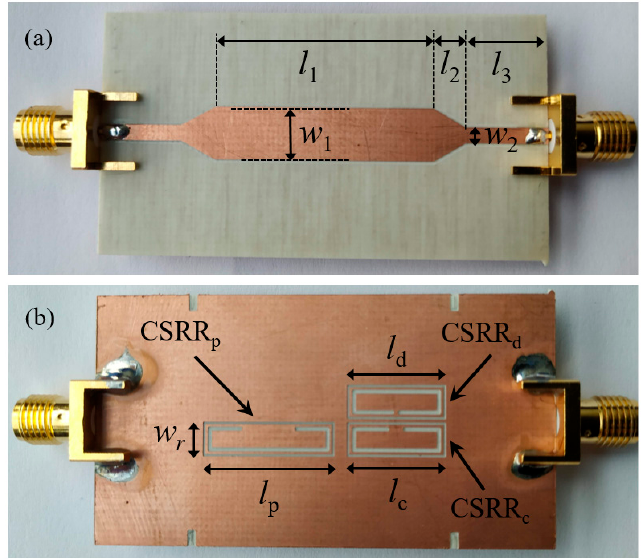
Figure 2. Photograph of the top ( a ) and bottom ( b ) side of the reader. The reader was implemented on the Rogers RO4003C substrate with thickness h = 0.81 mm, dielectric constant ε r = 3.38 and loss tangent tan δ = 0.0022. Dimensions are: l 1 = 26.6 mm; l 2 = 3.8 mm, l 3 = 10 mm, w 1 = 6.4 mm, w 2 = 1.9 mm, l c = l d = 10.5 mm; l p = 14.5 mm, w r = 2.9 mm. CSRR slots width is c = 0.5 mm, and ring splits are s d = 0.4 mm, s c = 1.6 mm and s p = 6.2 mm.